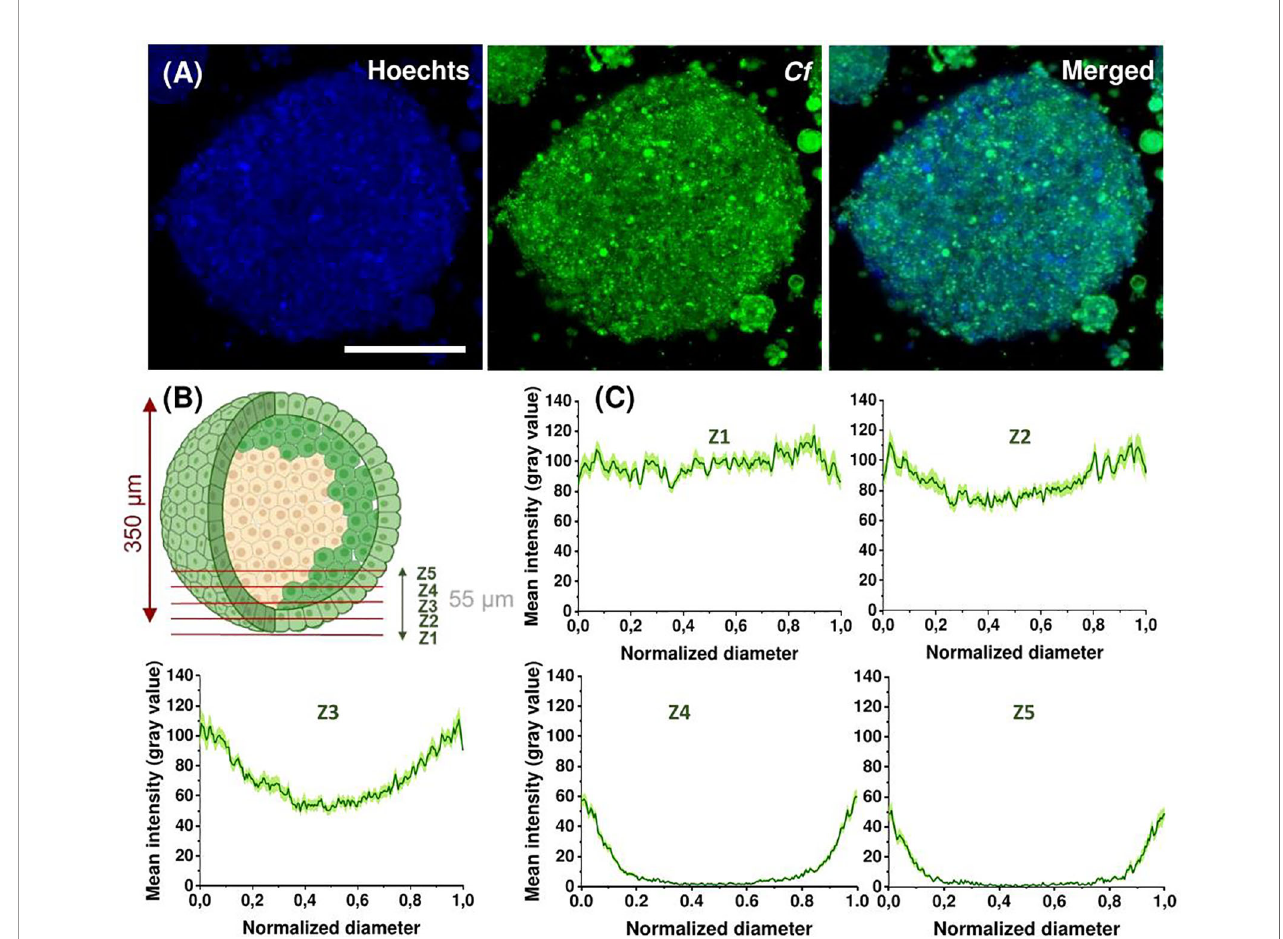
FIGURE 8 | Representative confocal images of EBC-1 spheroids after 3 h treatment with 10 µM Cf -Dhvar4 (green). Nuclei were stained with Hoechst 33342 (blue). Z-stack images were obtained starting at the surface of the spheroid with 11 µm intervals for a total of 55 µm into the spheroid, the presented images are from the 22.6-µm (z2) depths. Scale bar represents 200 µm (A) . Schematic representation of z sections (z1 – z5) (B) . Line scans of spheroids at different (z1 – z5) depth, mean intensities are grey values (0 – 255) averaged from two parallel spheroids (eight line scans for each, total n = 16 line scans), error stripes correspond to SEM (C) . Imaging was performed by Zeiss LSM 710 system with a ×40 oil objective with the parameters: Cf -peptides l ex = 488 nm, l em = 541 nm, nuclei l ex = 405 nm, l em = 467 nm (Hoechst